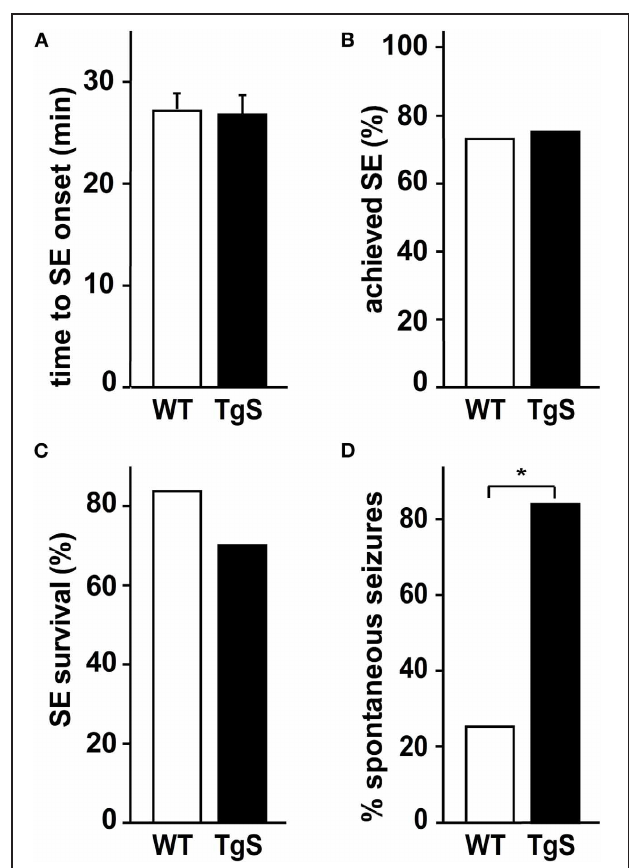
FIGURE 4 | SE and spontaneous seizures in TgS and WT mice. (A) Time (in min) was measured from pilocarpine injection to onset of SE. (B) Percentage of mice achieving SE. (C) Percentage of mice surviving 40min of SE (total number of injected animals: WT: n = 33, TgS: n = 44). (D) Percentage of mice presenting spontaneous seizures 1 month after SE ( ∗ p = 0.019, Chi-square test; number of monitored animals: WT: n = 8, TgS: n =